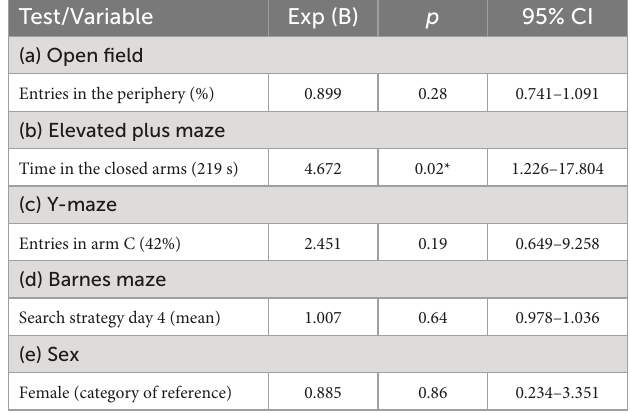
TABLE 3 Qualitative regression model to test the relationship between the variables of interest and the extreme behaviors of the ladder walking test.